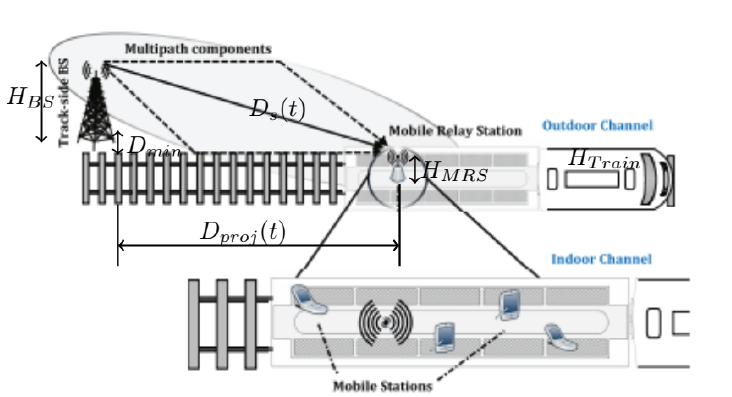
Figure 3. Trigonometrical representation of open case environment for time-varying